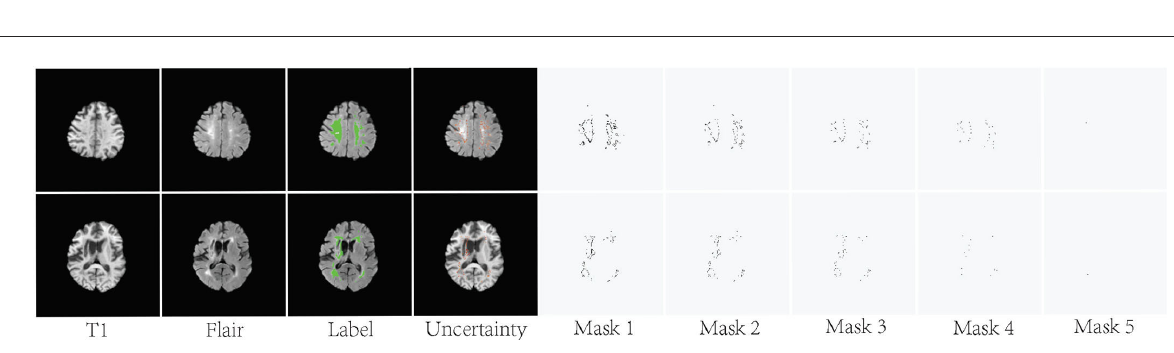
and ensemble models, combining U-Net, SE-Net, and multi- scale features, to automatically segment WMHs and estimate their volumes and locations. Sundaresan et al. (2021)